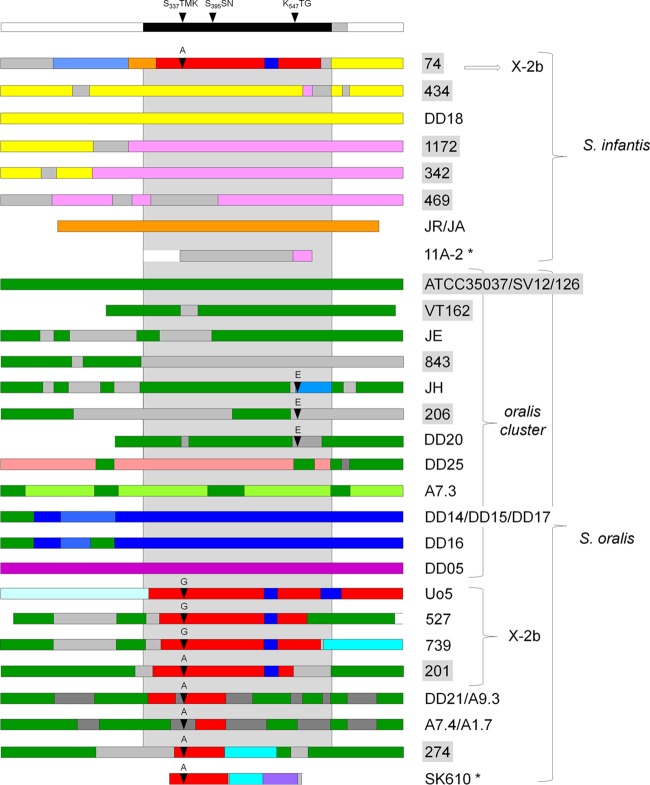
Mosaic structure of PBP2x variants of S. infantis and S. oralis. Mosaic gene structures were deduced by comparing PBP2x sequences. Highly similar sequences (<5% difference) are shown in the same colors; unrelated sequences of unknown origin are in gray. The red block in S. infantis 74 indicates the 2x-23F group. The domain structure and active site boxes are indicated on top; the central transpeptidase domain is indicated by the gray area. Mutations at sites 338 and 552 are indicated. The strains are indicated on the right. Sequences were retrieved from GenBank (gray); those described by Jensen et al. (10) are marked with *. All others have been described in (10), or are part of this study. Accession numbers: 527, KY292529; 739, KY292532; SV12, KY292537; JA, KY292545; JE, KY292547; and JH, KY292546.